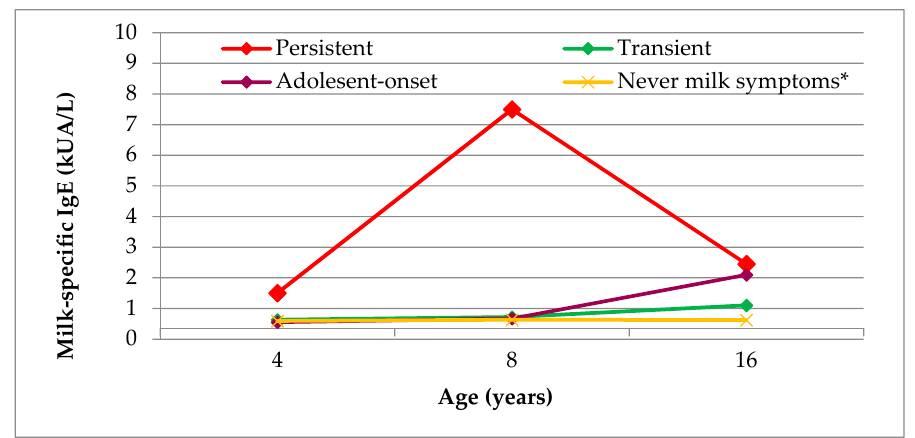
Figure 3. Median milk IgE levels amongst those with milk IgE reactivity ( ≥ 0.35 kU A /L) at ages 4, 8, and 16 years in relation to phenotype of milk-related symptoms ( N = 1543). * Never milk symptoms to the corresponding age. Compared to mean milk IgE levels at each amongst those with persistent symptoms, all levels are significantly lower ( p < 0.05) for those with the other phenotypes.